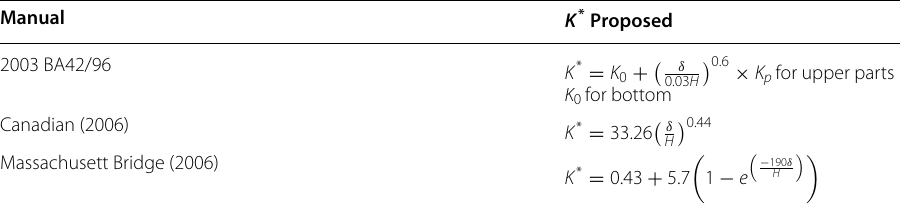
Table 2 Proposed lateral earth pressure coefficient for unreinforced soil behind integral bridge